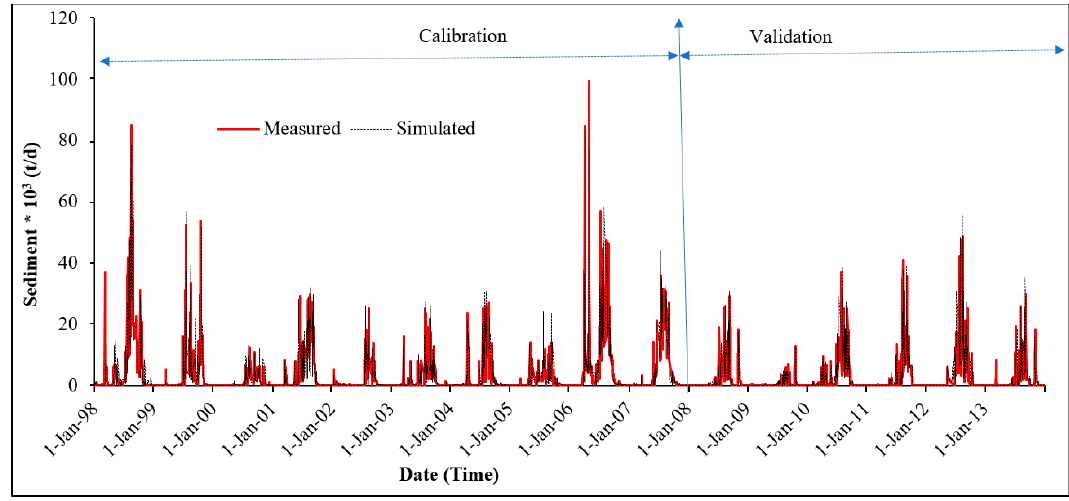
Figure 7. Sediment yield calibration and validation at Maki gauging station.